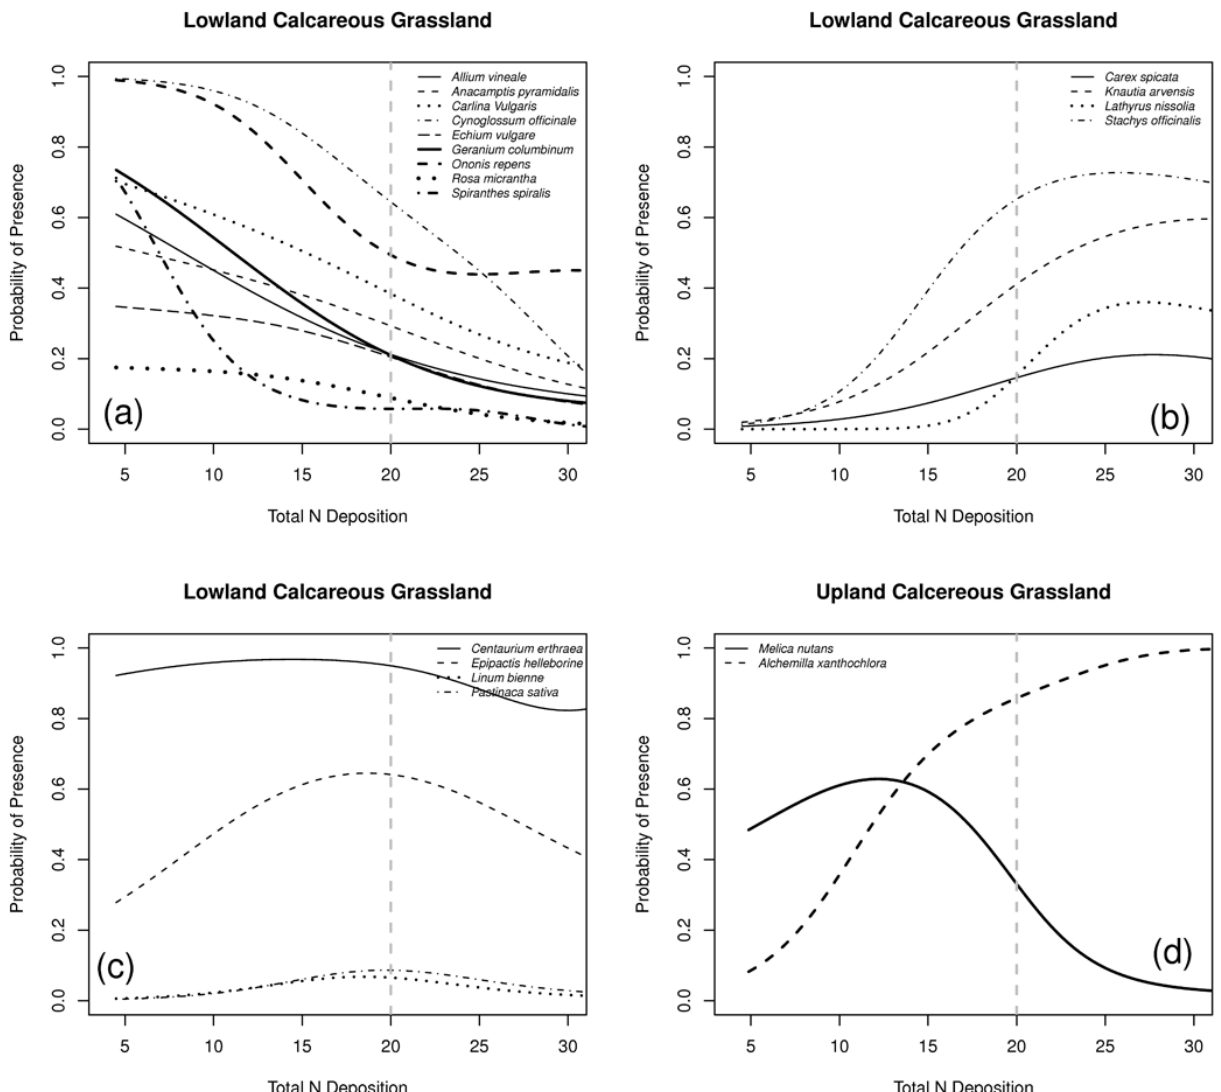
Fig. 2. Change in probability of presence for species showing statistically significant relationships to N deposition in calcareous grasslands in the Vascular Plant database against increasing total inorganic N deposition (kgNha − 1 yr − 1 ) . The dashed grey line indicates the midpoint of the critical load range for calcareous grasslands as defined by Bobbink and Hettelingh